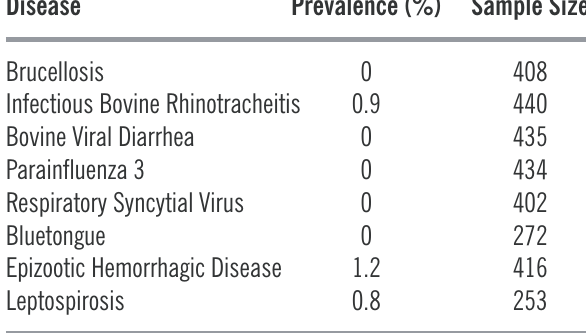
Table 2. Disease prevlence (1988-1997) in Yukon north- ern mountain caribou (from Farnell et al., 1999).